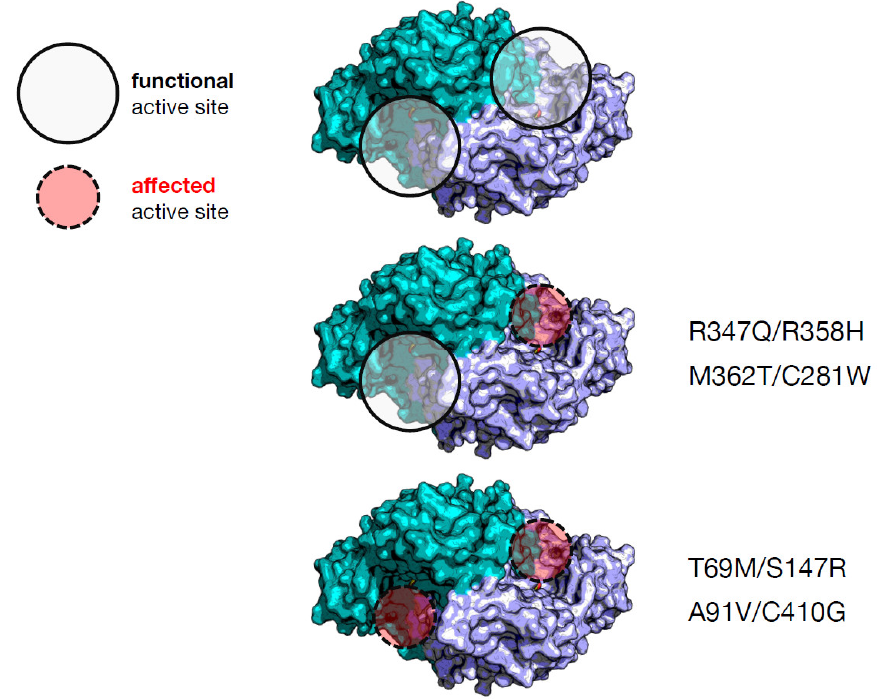
Figure 3. Possible effect on the active sites of AADC through combination of amino acid alterations in the heterodimers synthesized by compound heterozygous patients. The protein coordinates are taken from [37]. The two different colors refer to the functional AADC dimer displaying the antisymmetric arrangement. The circles are pointed on the active sites that could be altered or not by the amino acid alterations in the four heterodimers.